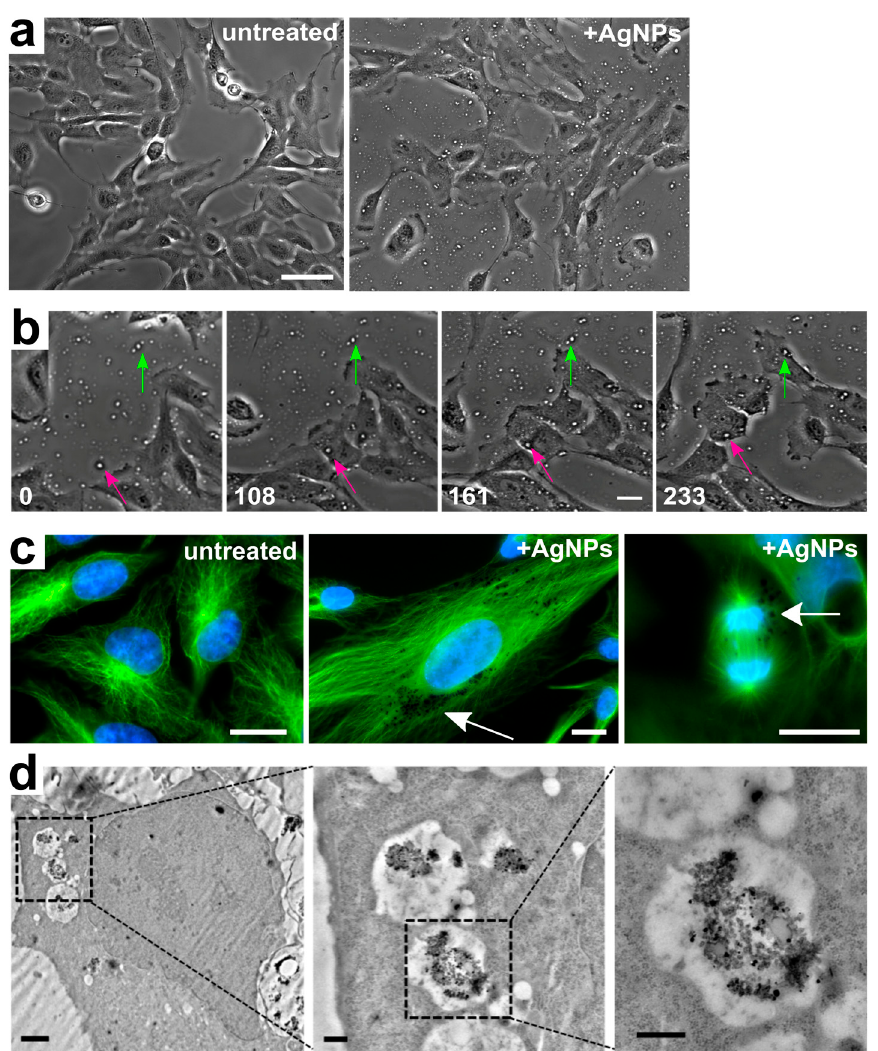
Figure 2. Silver nanoparticle internalization. ( a ) Still images from untreated ( left ) and AgNP-treated ( right ) live cell samples showing the presence of refractive dots (AgNPs) on and around the cells in the treated ( right ), but not in the untreated ( left ) sample (see also additional file 2). Scale bar, 10 µ m. ( b ) Still images from time-lapse microscopy showing AgNPs becoming engulfed by individual cells. The green and pink arrows point at particles that are extracellular in the initial frame, but become engulfed by individual cells at subsequent time points and persist as intracellular particles (see also additional file 3). Numbers indicate elapsed time in min; Scale bar, 10 µ m. ( c ) Representative images of fixed cells fluorescently stained for microtubules ( green ) and DNA ( blue ). The left image shows untreated cells. The middle and right images show an interphase and a mitotic cell, respectively, treated with 50 µ g / mL of AgNPs. Arrows point to dark fluorescence-exclusion regions, assumed to be pockets of intracellular AgNPs. Scale bars, 10 µ m. ( d ) Progressively magnified images from a transmission electron micrograph showing an example of a cell with internalized AgNPs contained in intracellular vesicles. Scale bars, 2 µ m ( left panel ), 500 nm ( middle and right panels